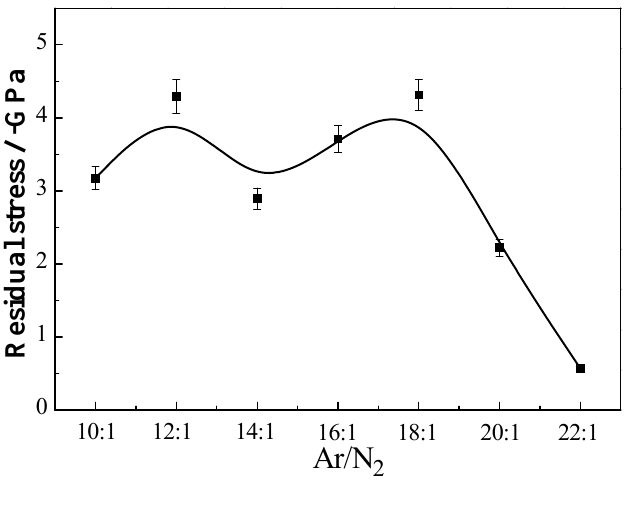
O multilayers at different Ar/N 2 3